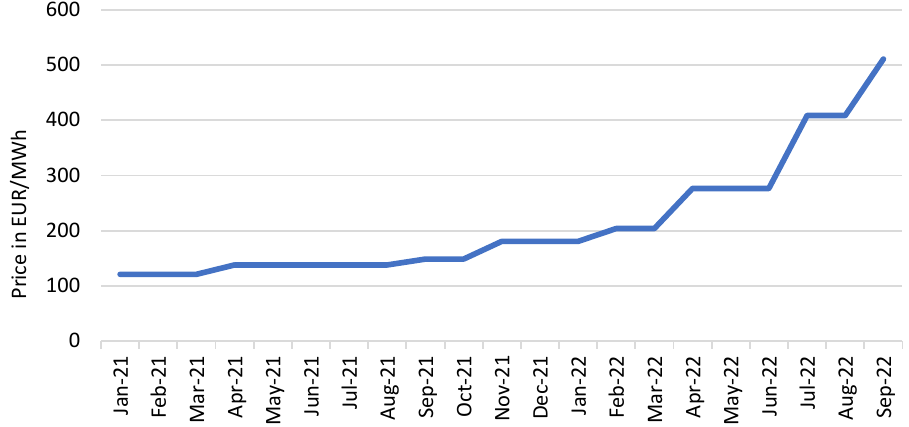
Figure 7. Business electricity rates in Poland—tariff C11 [49].